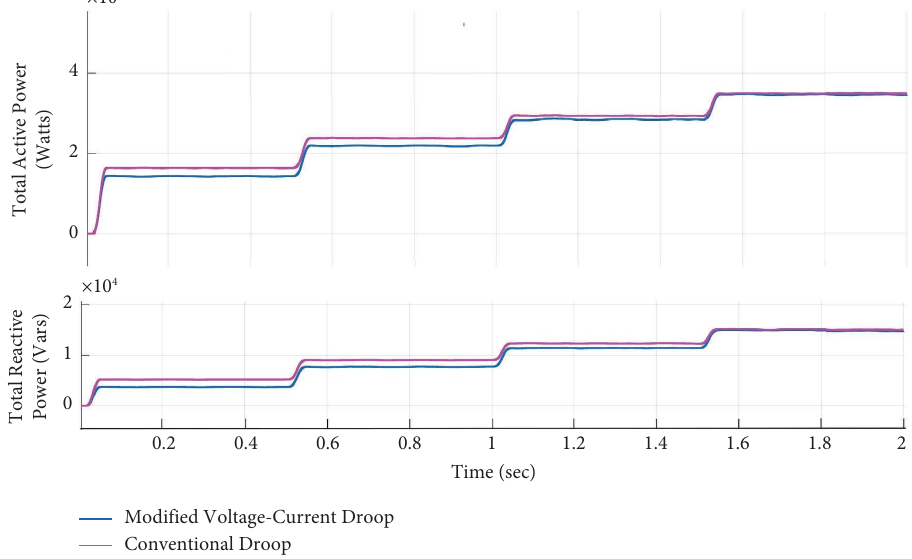
Figure 19: Representation of power consumption of 9 bus test